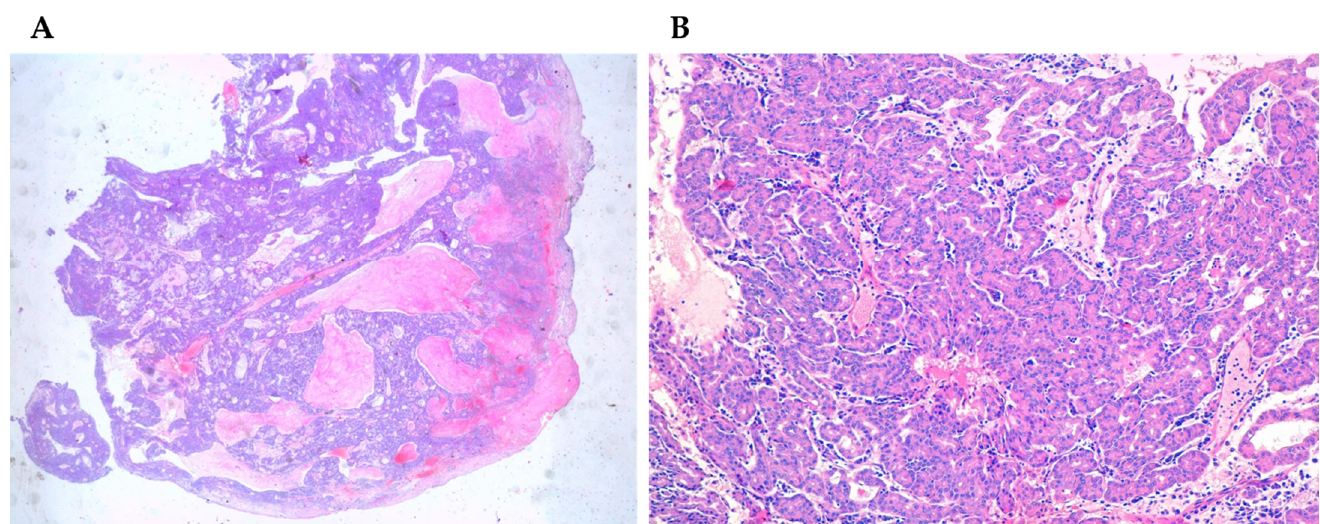
Figure 3. ( A ) Acinic cell carcinoma (4×) stained with hematoxylin-eosin. ( B ) Acinic cell carcinoma (40×) stained with hematoxylin-eosin.